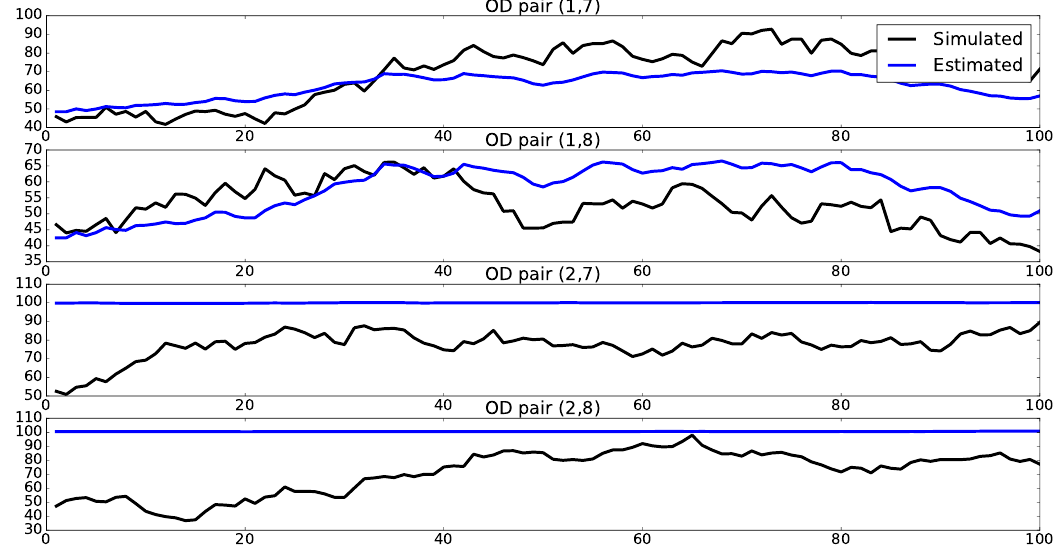
Figure 8. Simulated and estimated mean OD flows with observed traffic volumes on link 1. Horizontal axes show time periods, while vertical axes show magnitude of OD